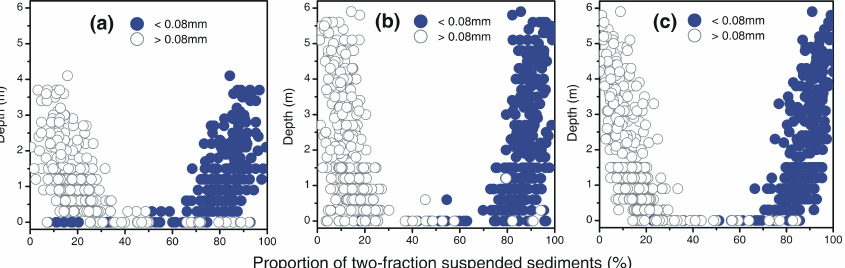
Figure 5. Vertical profiles of proportions of the two-fraction sediments ( > 0.08mm and < 0.08mm) in the cross section of the Sanhuhekou gauge during the passage of a flood with a flow discharge from 1000 to 3200m 3 s − 1 in 2012. (a) 540m distance from the starting point of the cross section in the left bank, (b) 620m distance from the starting point of the cross section in the left bank, (c) 700m distance from the starting point of the cross section in the left bank.